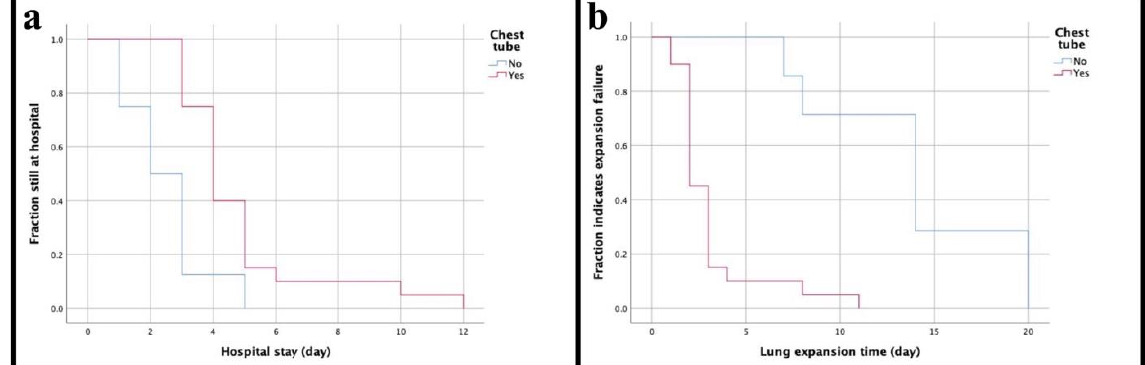
Figure 2. The mean hospital stay was longer in the chest tube group (Figure 2a), while the mean time for the lung expansion was longer in conservative group (Figure